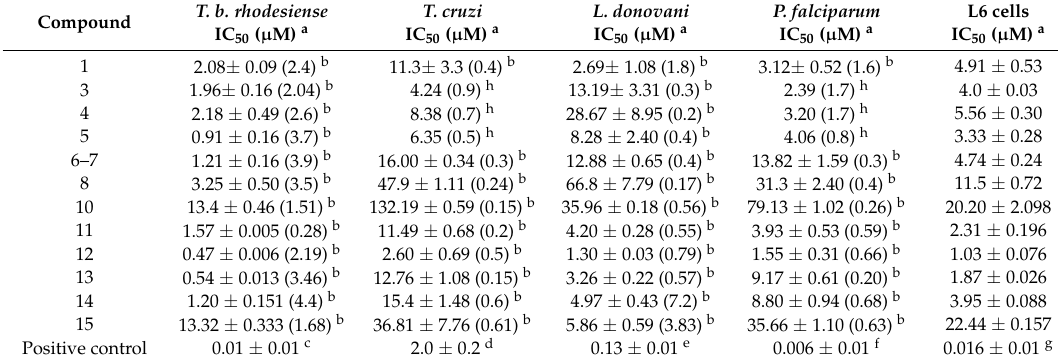
Table 5. In vitro activity of compounds 1 , 3 – 8 , and 10 – 15 against T. b. rhodesiense (STIB 900), T.